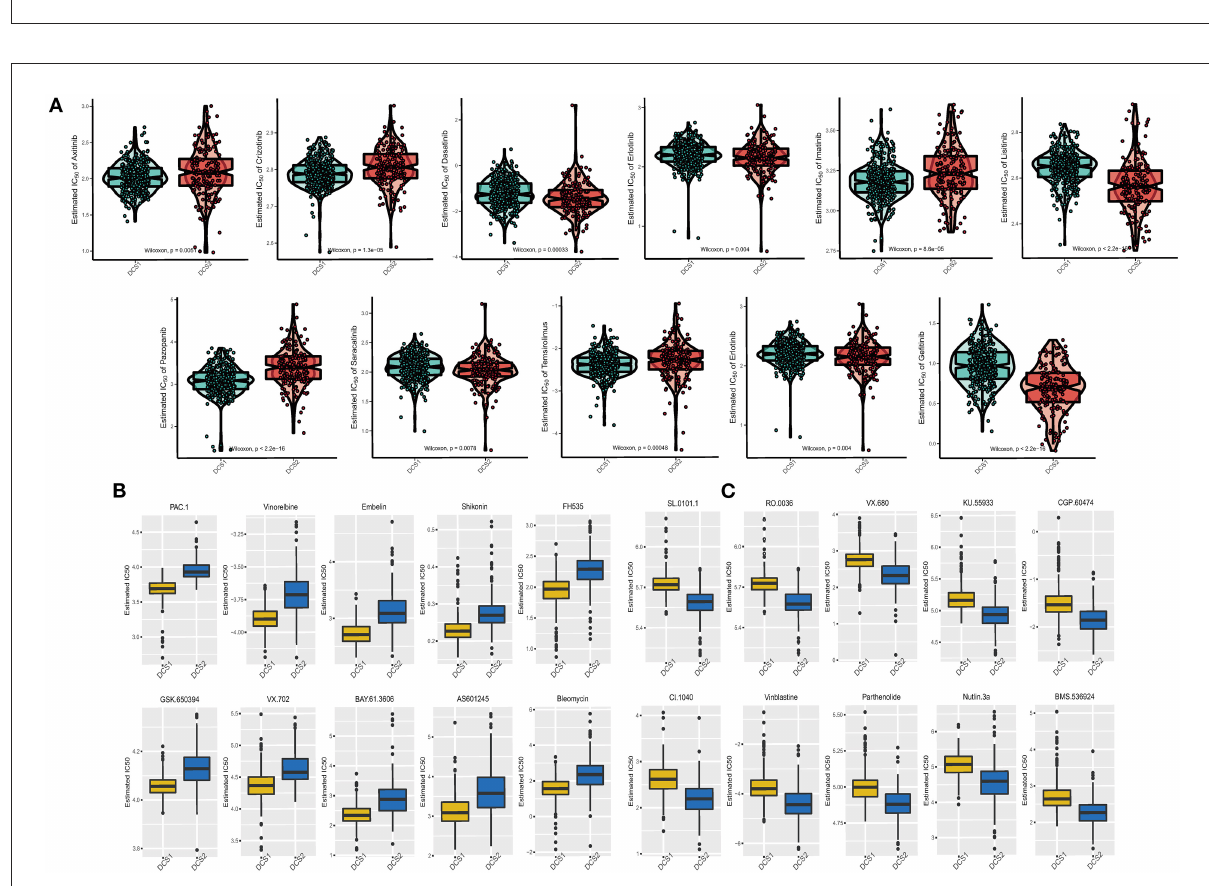
FIGURE7 Drug sensitivity difference between DCS1 and DCS2. (A) Distribution of IC50 value of clinical chemotherapy agents. (B,C) Novel identified molecular agents for DCS1 and DCS2,